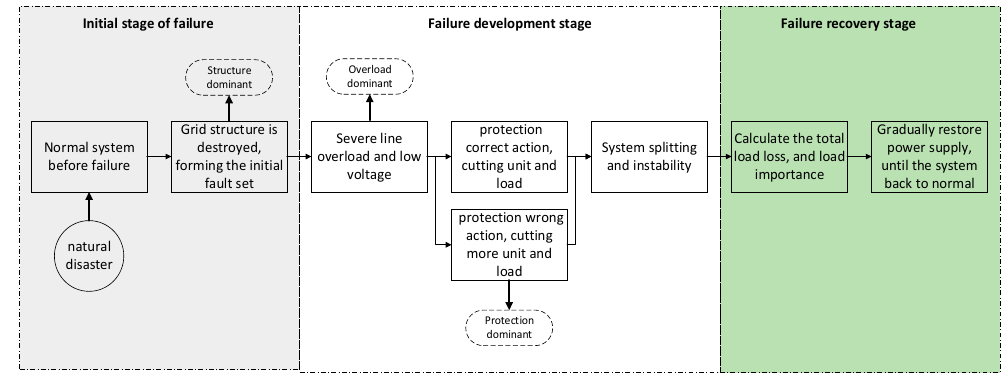
Figure 1. Development of chain failure.